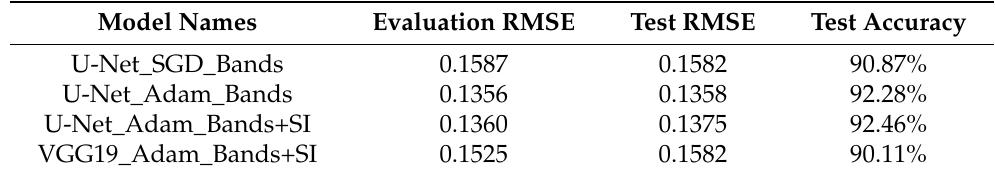
Table 1. Model performance on testing data as measured by RMSE and test